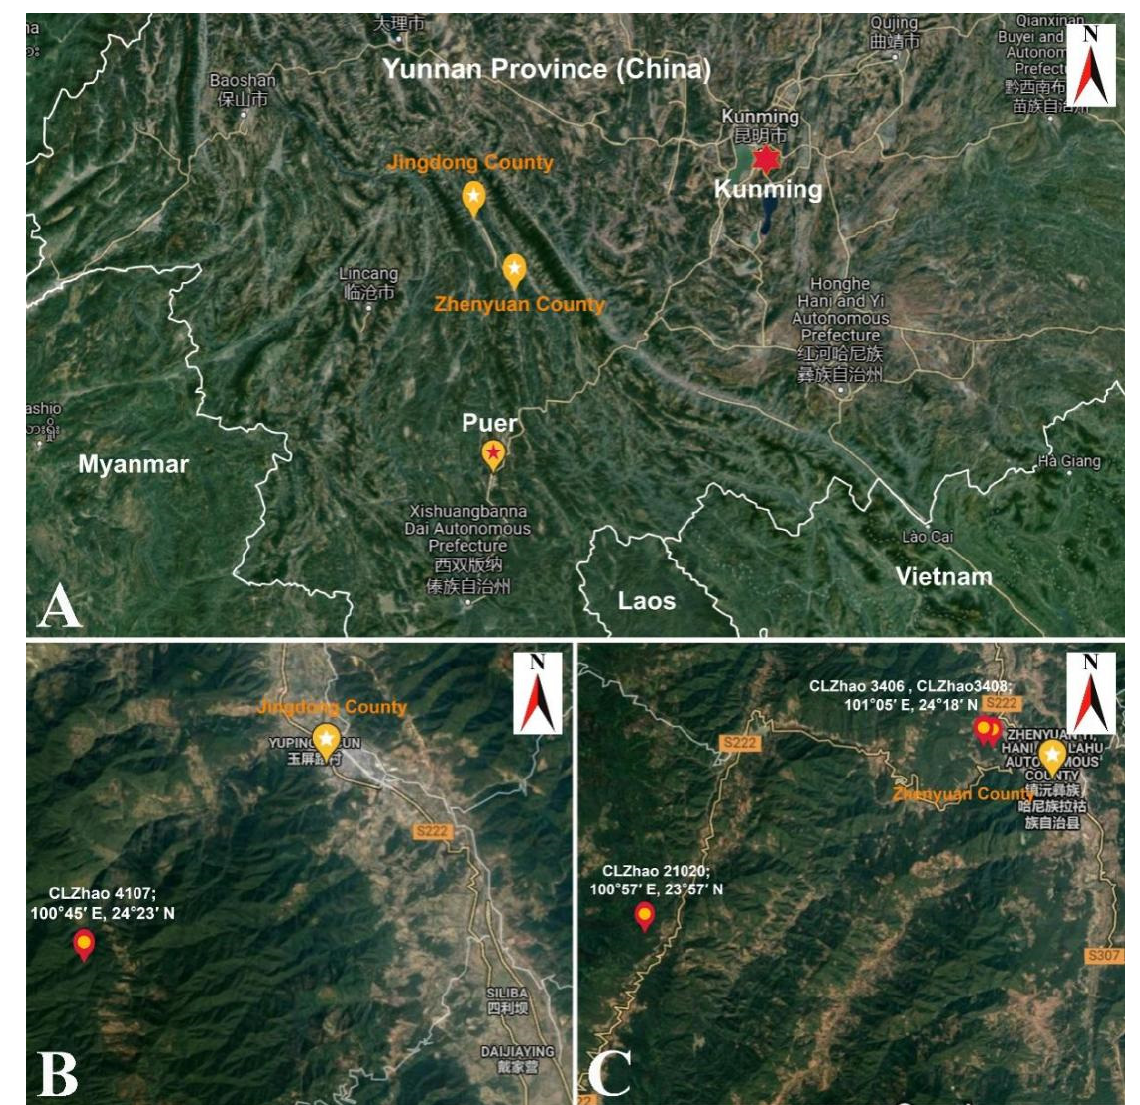
Figure 1. The localities of new Thelephora species. ( A ) Jingdong county and Zhenyuan county in Yunnan province. ( B ) The locality of Thelephora wuliangshanensis strain (Holotype: CLZhao 4107) in Jingdong county. ( C ) The locality of T. wuliangshanensis (CLZhao 21020) and T. grandinioides (Holotype: CLZhao 3406; CLZhao 3408) in Zhenyuan county. Source: Map data ©2021 Google.